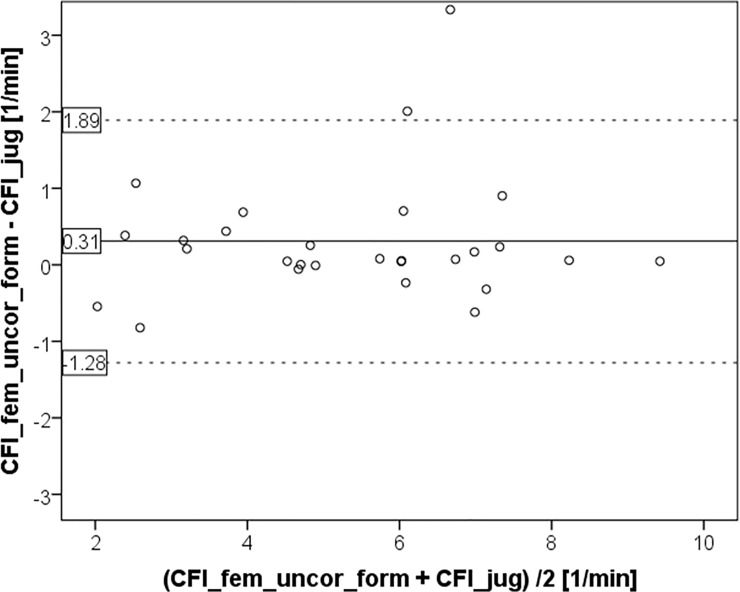
Bland Altman plot comparing cardiac function index CFI_jug derived from jugular indicator injection to cardiac function index CFI-fem_uncor_form which was derived from femoral indicator injection without activation of a potential correction by the device, but corrected with the formula suggested for correction of femoral indicator injection derived global end-diastolic volume index GEDVI: GEDVIcorrected [mL / m2] = 0.539 * GEDVIuncorrected—15.17 + 24.49 * CIuncorrected 2.311* BWideal. CFI_fem_uncor_form was calculated by multiplying CFI_fem_uncor with the ratio GEDVuncorrected/GEDVcorrected.GEDV(I): global end-diastolic volume (index). CI: Cardiac index.